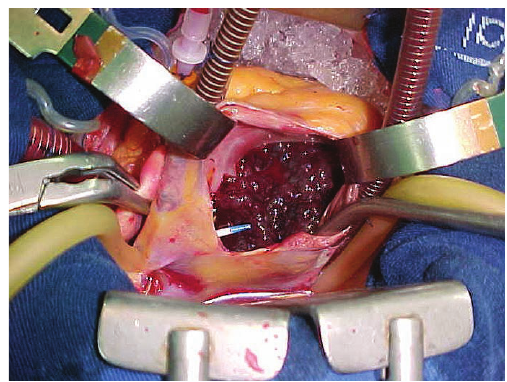
Fig. 2 - Mixoma de átrio direito - Visibilização de volumosa massa tumoral após atriotomia direita. Tumores primários do coração são entidades raras, ocorrendo em 0,0017% em séries de autópsias [4].